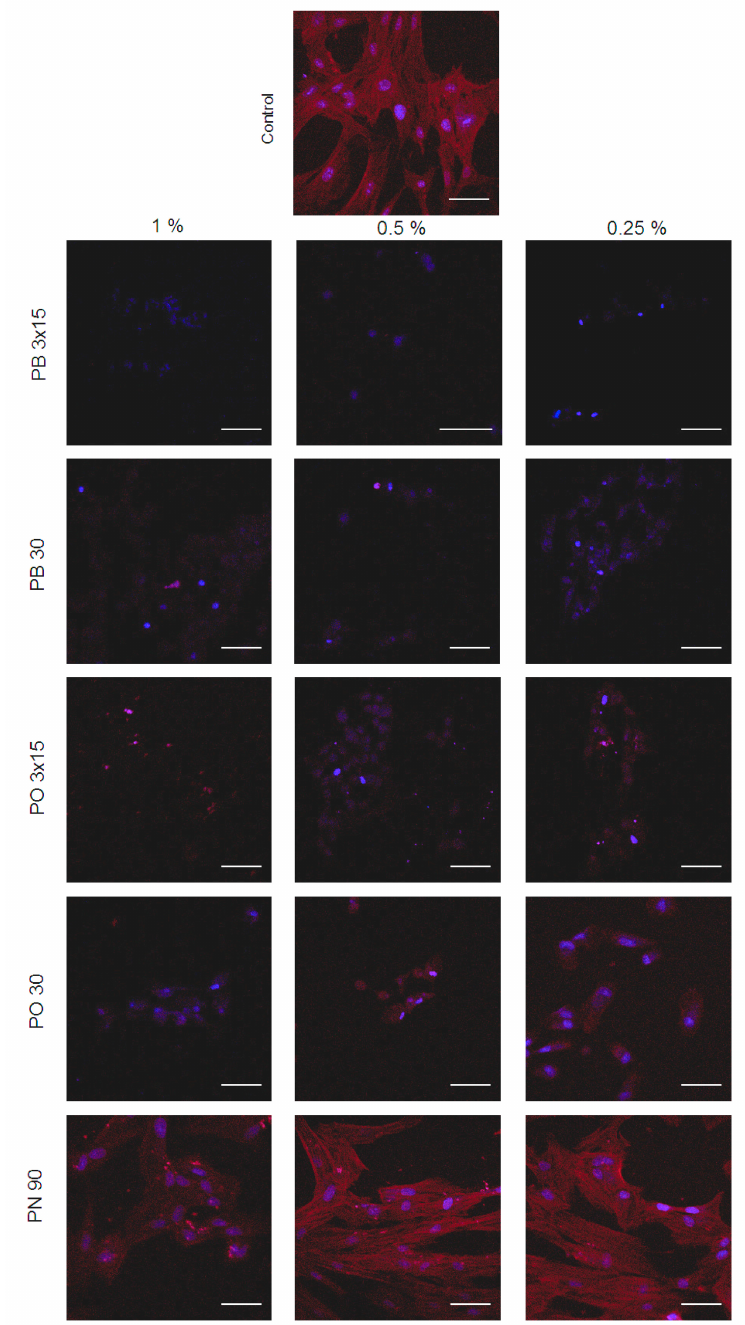
Figure 5. Representative immunofluorescence micrographs revealing the cytoskeletal organisation of h DPSCs exposed to control and bleaching products. Cultured h DPSCs were treated with undiluted extracts of bleaching products for 24 h. For staining filamentous actin (F-actin), cells were incubated with CruzFluor594-conjugated phalloidin (Santa Cruz Biotechnology, Dallas, TX, USA). Nuclei were counterstained with 4,6-diamidino-2-phenylindole dihydrochloride (DAPI) (blue). Scale bar = 150 μ m.